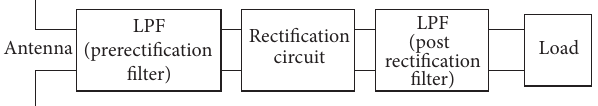
Figure 1: Block diagram of rectenna.